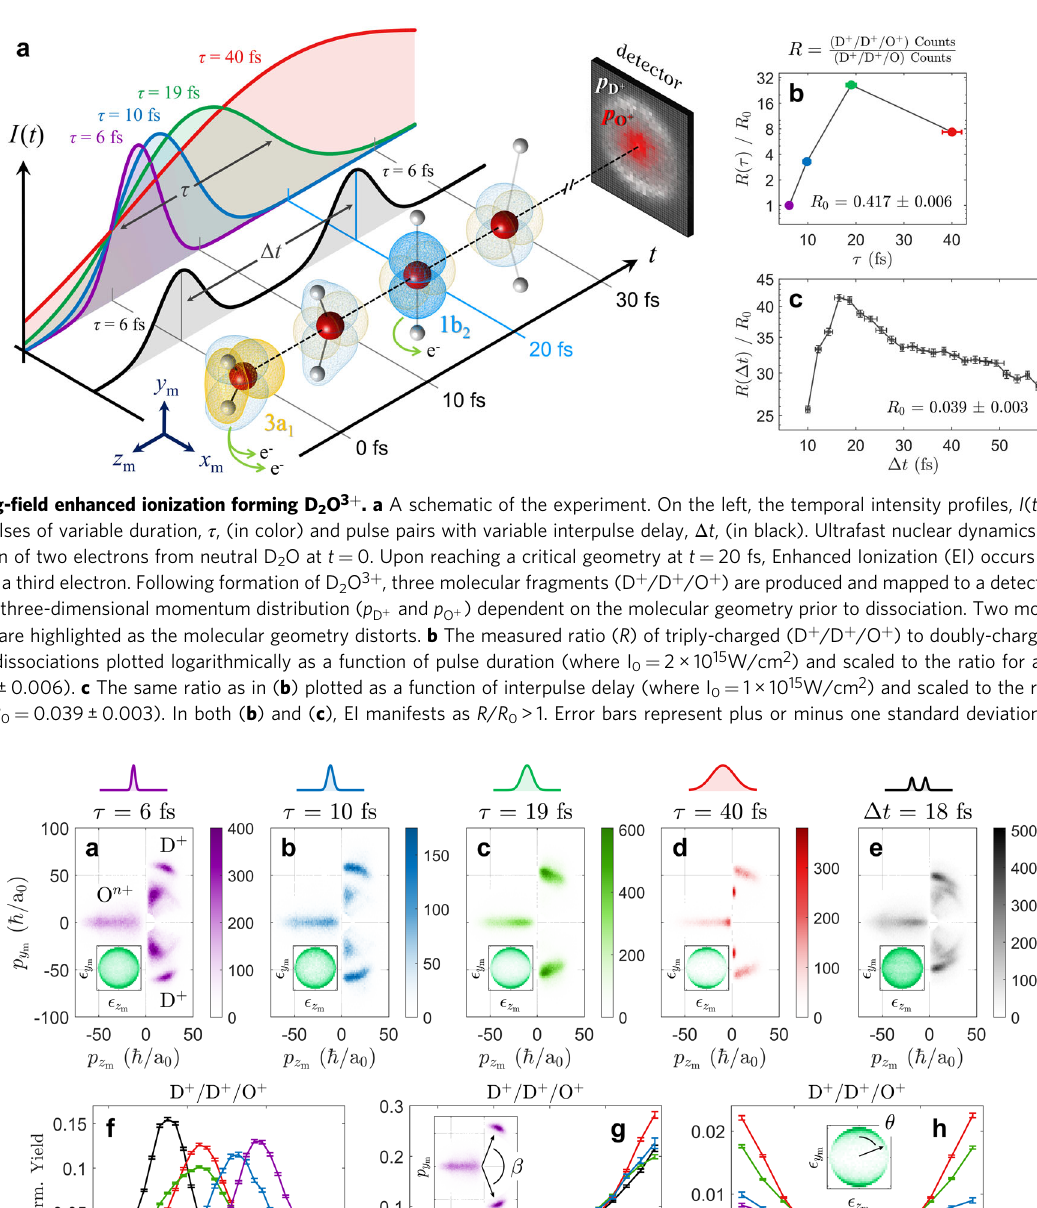
Fig. 2 Pulse-shape dependence of D 2 O 2 + & D 2 O 3 + fragment momenta. a – e The molecular-frame momentum distribution (in p z fragments (D + /D + /O n + where n = 0,1) present in all D + /D + coincidences. In each plot, the D + momentum distributions appear in the upper and lower > 0) while the O n + momentum distribution appears on the left ( p right quadrants ( p z m ranging from 6 to 40 fs. e Corresponds to ionization via pulse pairs with an interpulse delay of 18 fs. The inset in ( a – e ) displays a crushed 2-dimensional projection (in ϵ z and ϵ y ) of the normalized 3-dimensional polarization vector ( ^ ϵ ) in the molecular frame. f – h One-dimensional distributions of the total m m kinetic energy release (KER), momentum-frame bend-angle, β ¼ arccos ð ^ p D þ D + /O + distribution displayed in ( a – e ). Error bars represent plus or minus one standard